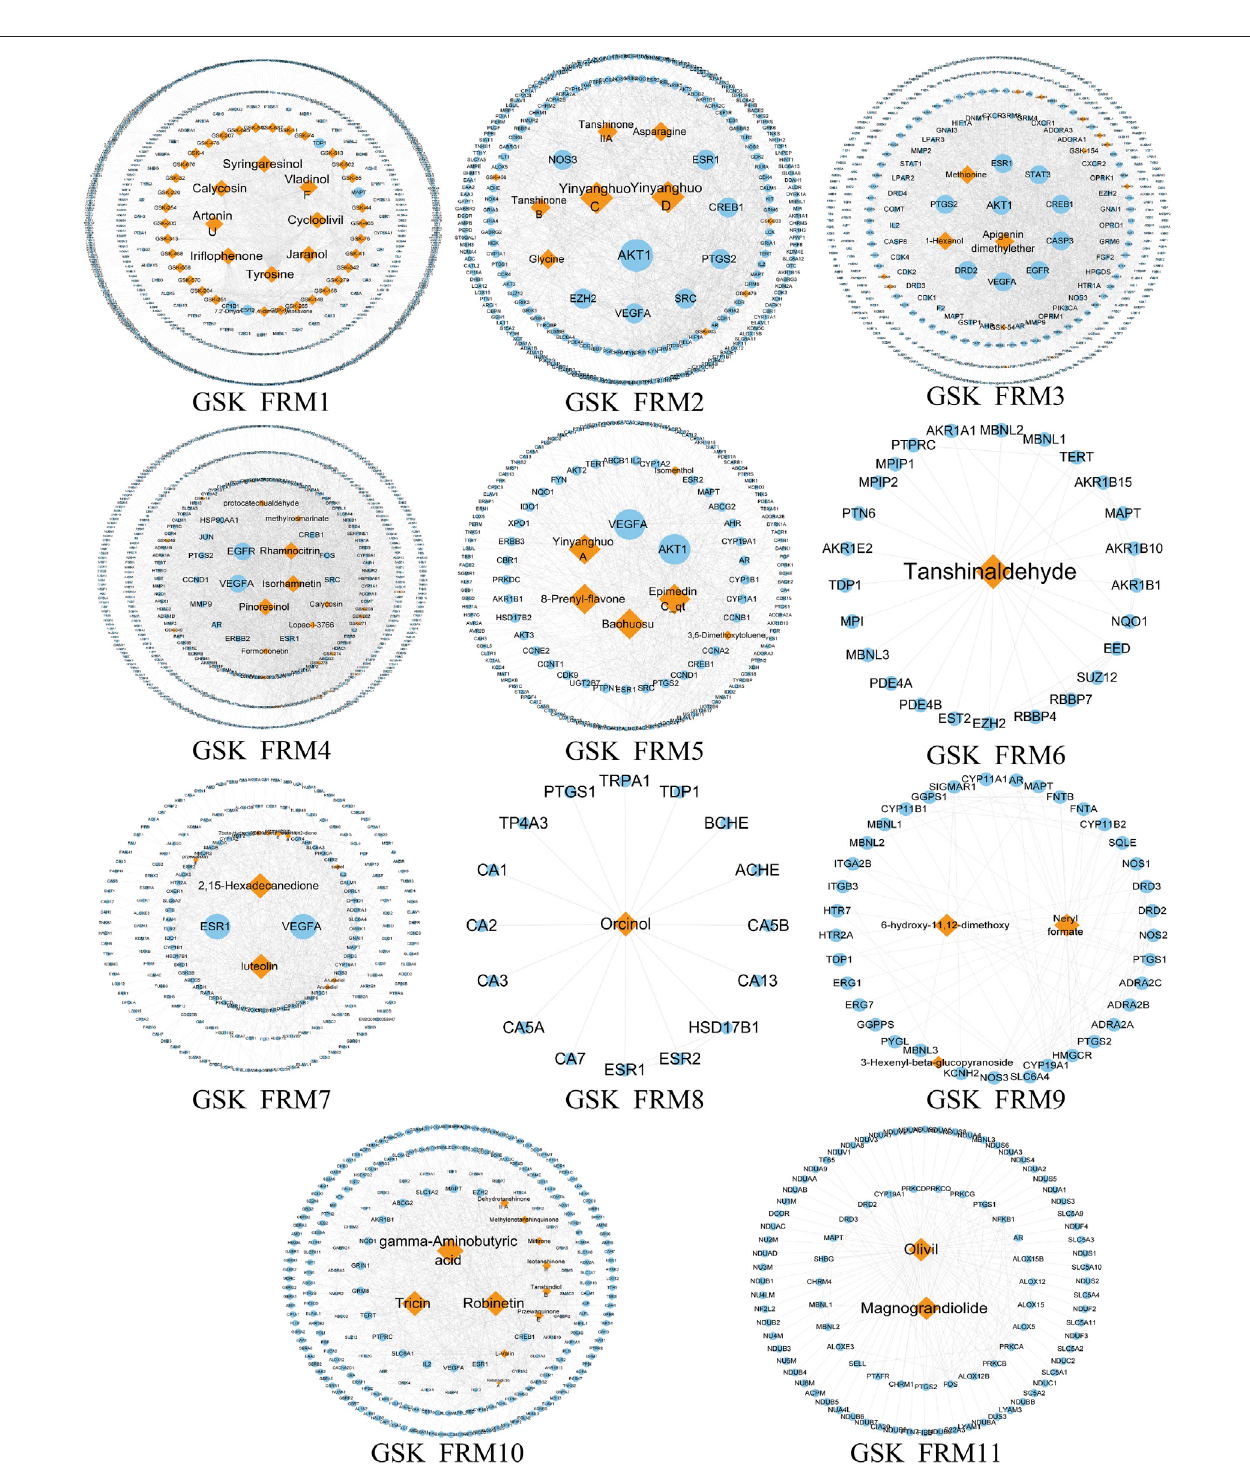
FIGURE 3 | ThepredicatedFRMsoftheC-TnetworkinGSK.TheorangenodesrepresentthecomponentsinGSK,and thebluenodesrepresenttherelated targets.